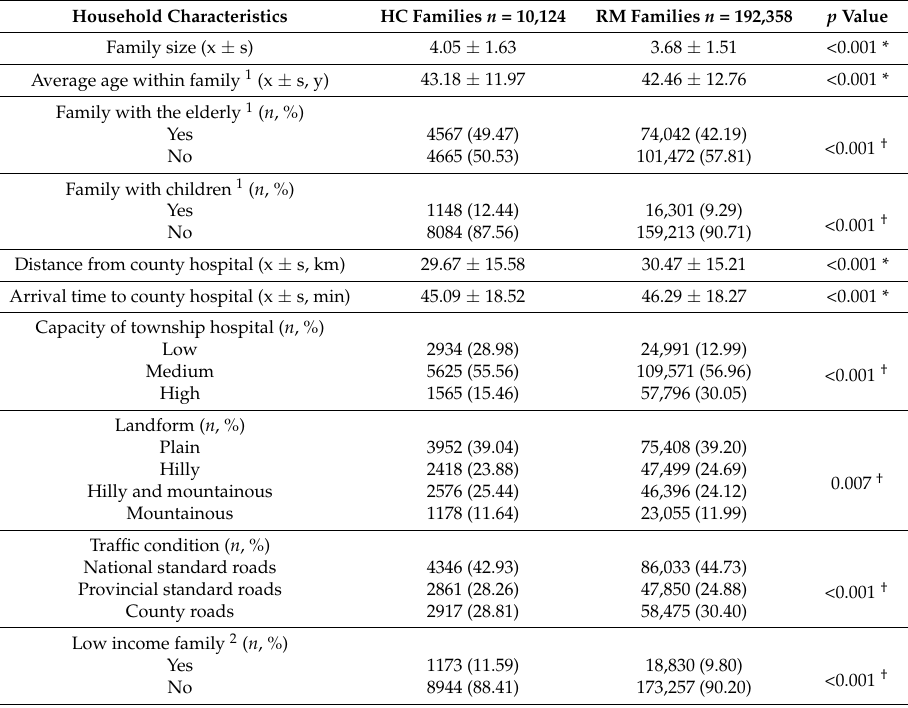
Table 4. Household characteristics of different family groups in Macheng in